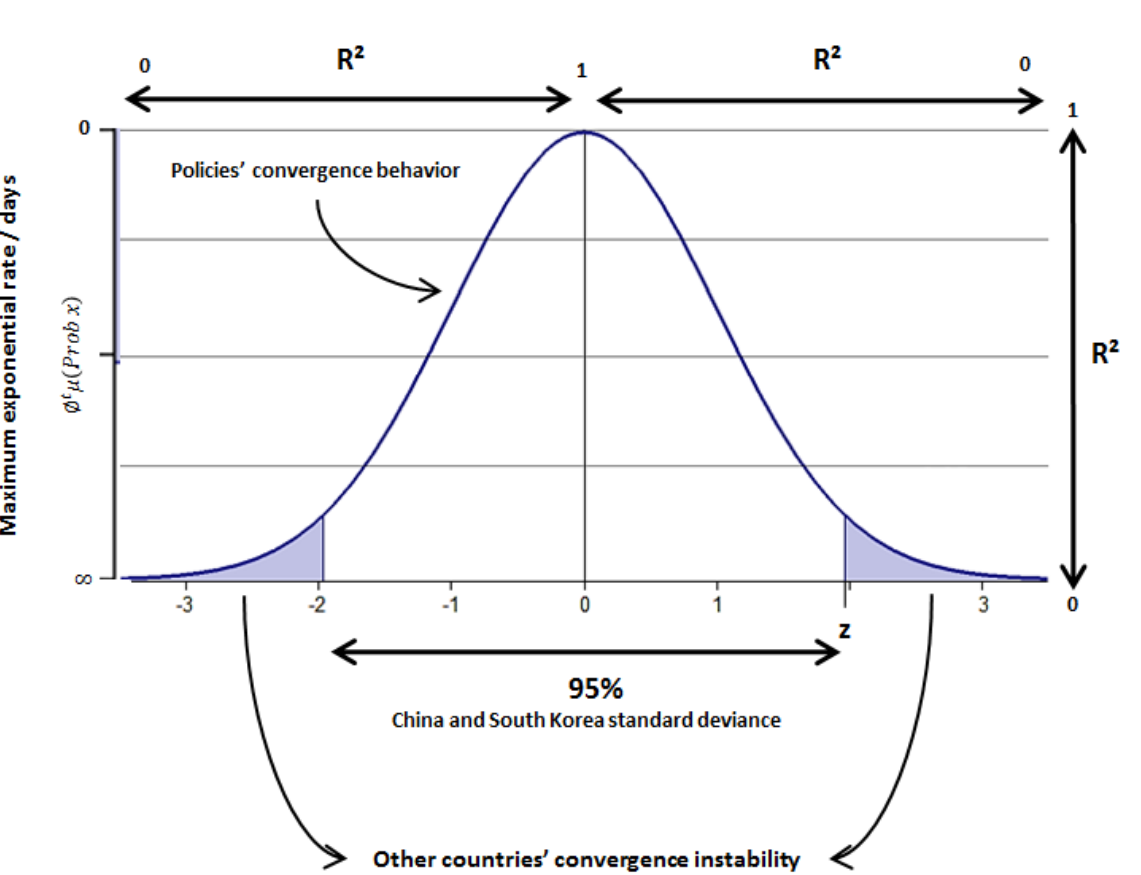
Figure 3. Representative scheme of SARS-CoV-2 reproductive patterns among countries whose policies might or might not converge toward a very low maximum exponential rate of infection per population/days. Note that countries with a low maximum exponential rate (Table 2) also present active infection patterns, with this feature being a nonconvergence of the type of policies adopted and, hence, expressing an exponential probability of infection constant growth (false null